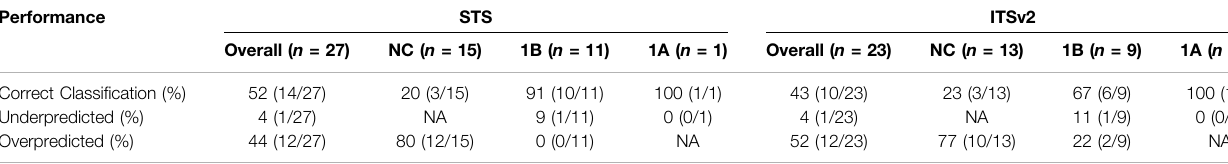
NC, GHS Not Classi fi ed (nonsensitizer); NA, not applicable.